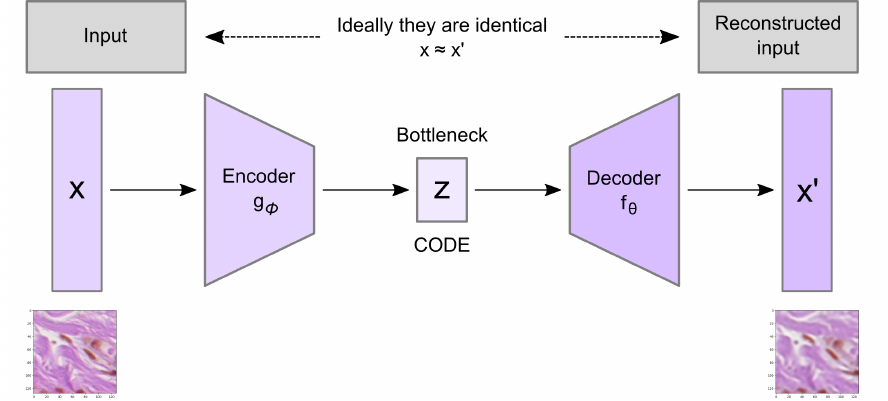
Figure 5. Schema of a basic autoencoder including the encoder, decoder, and code parts. The model contains an encoder function g ( . ) and a decoder function f ( . ) parameterized by φ and θ , respectively. The low-dimensional code learned for input x in the bottleneck layer is z and the reconstructed input is x (cid:48)